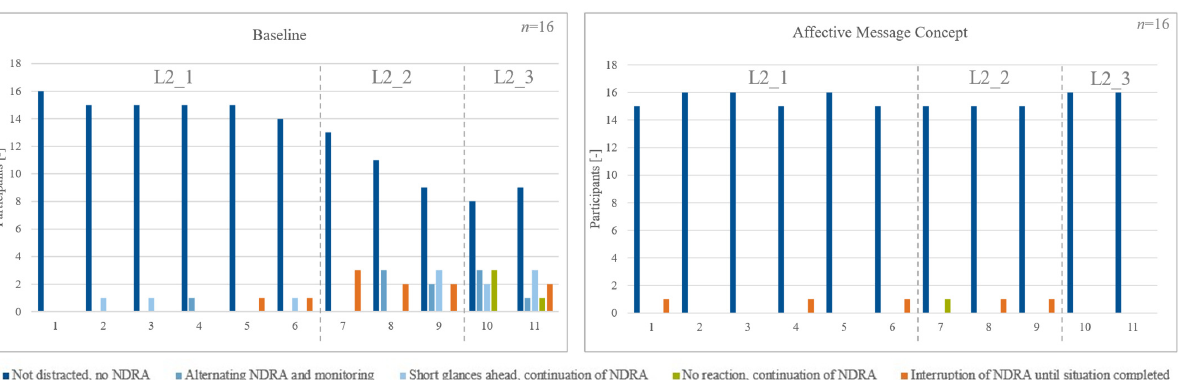
Figure 7. Overview of NDRA engagement divided by driving segment and HMI concept. In line with monitoring behavior and overall NDRA engagement, baseline participants’ engagement increased over time (max: 50% engaged), while not more than one advanced group subject engaged per intersection (see Figure 8).